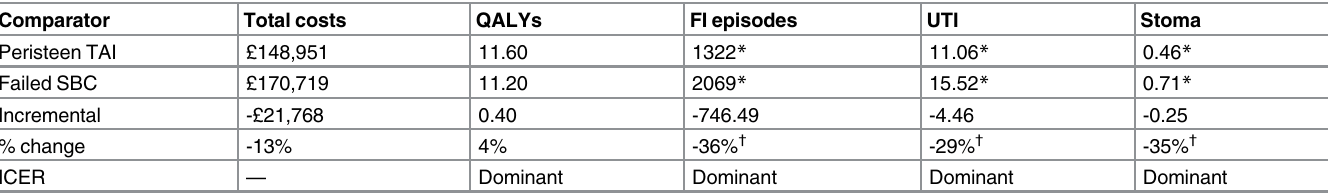
Table 5. Cost-effectiveness results